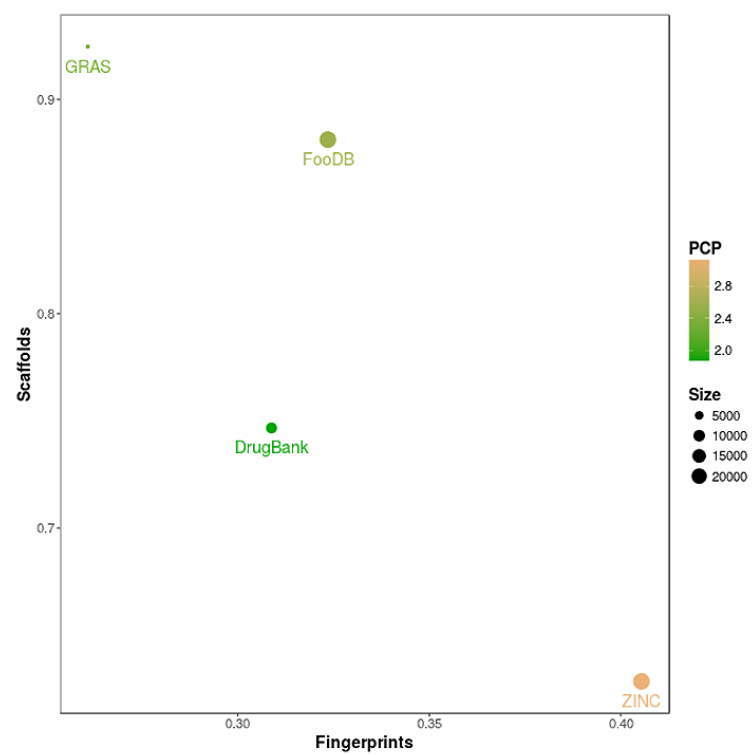
Figure 4. Consensus Diversity Plot of FooDB and reference data sets. The structural diversity of each data set is represented on the X-axis and was defined as the median Tanimoto coefficient of MACCS keys fingerprints. The scaffold diversity of each database is represented on the Y-axis and was defined as the area under the corresponding scaffold recovery curve. The diversity based on physicochemical properties (PCP) was defined as the Euclidean distance of six auto-scaled properties (SlogP, TPSA, AMW, RB, HBD, and HBA) and is shown as the filling of the data points using a continuous color scale. The relative number of compounds is represented with a different size of the data points (smaller data sets are represented with smaller data